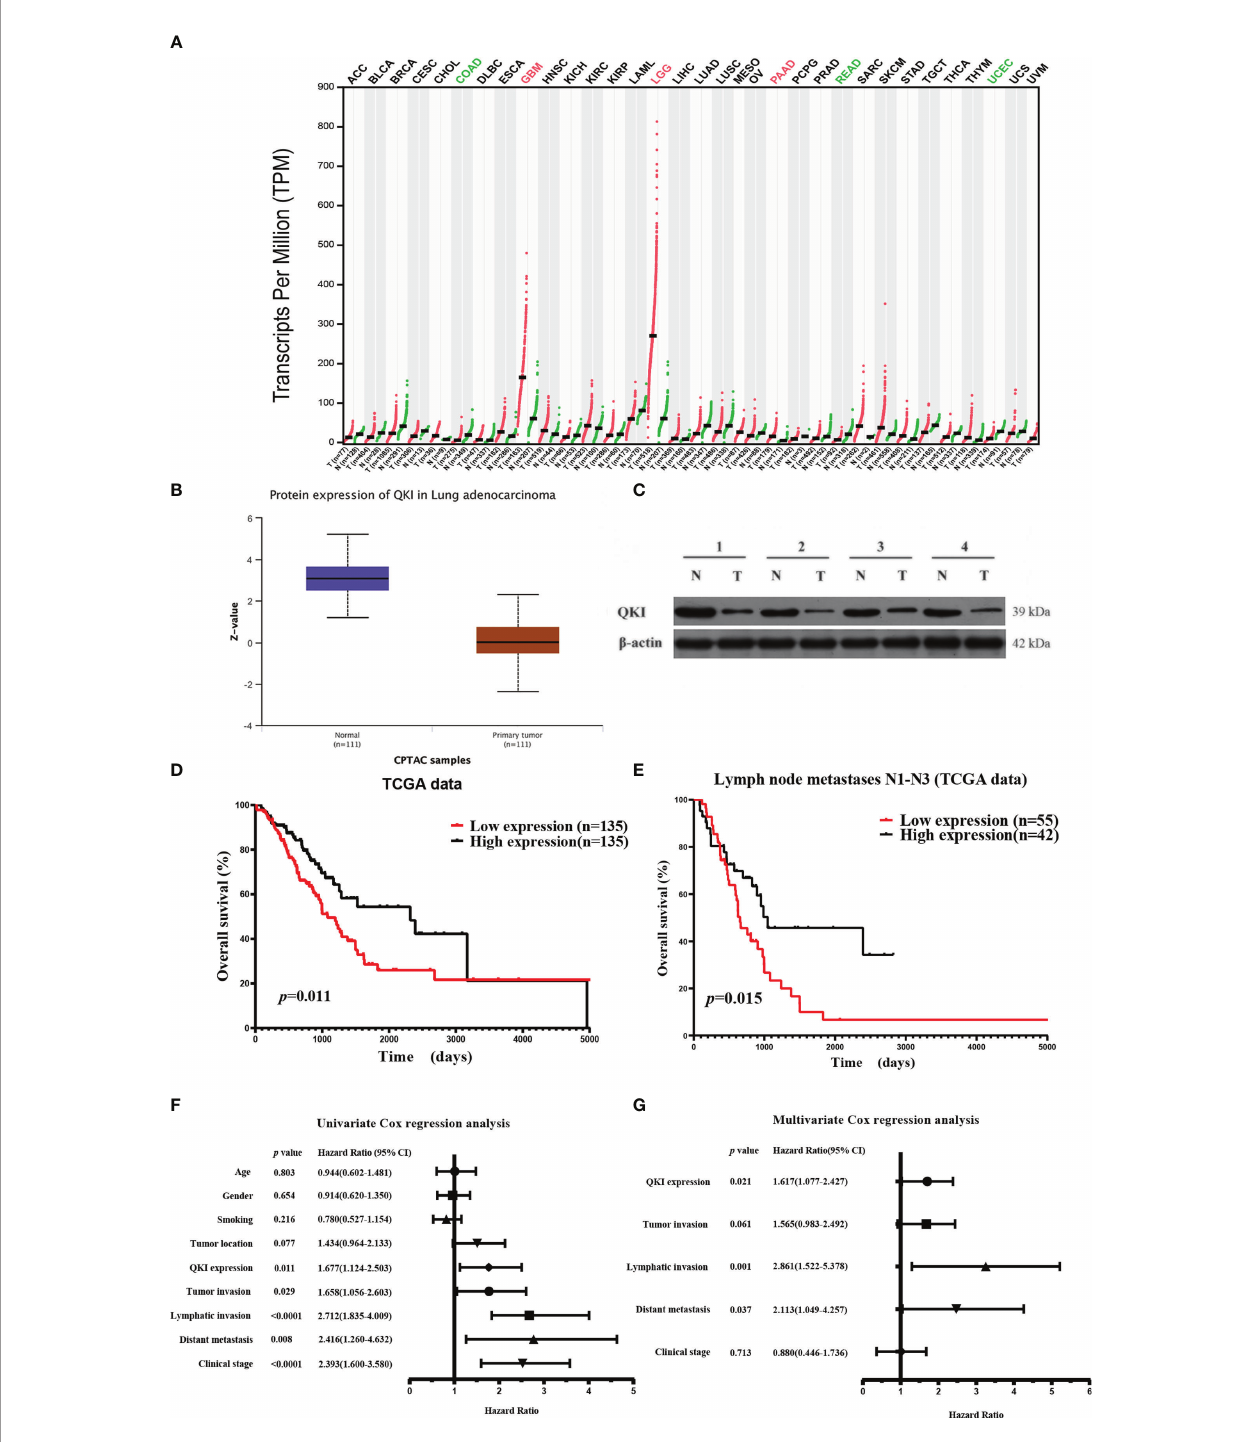
FIGURE 1 | Elevated QKI expression improved prognosis in patients with non-small lung cancer (NSCLC). (A) QKI expression pro fi le across several tumor samples and paired healthy tissues. (B) QKI protein expression levels in lung adenocarcinoma (NSCLC) and normal tissue samples were analyzed using CPTAC samples ( P < 0.05). (C) QKI protein expression in tumor (T) and normal tissue (N) from four patients. (D) Kaplan – Meier (KM) overall survival (OS) analysis of QKI expression in lung adenocarcinoma by using the TCGA samples ( n = 270; low expression vs. high expression; HR = 1.67, 95% CI = 1.13 – 2.47, P = 0.011, log-rank test). (E) KM OS analysis of QKI expression in patients with NSCLC with lymph node metastases N1 – N3 in the TCGA samples ( n = 97; low expression vs. high expression; HR = 1.93, 95% CI = 1.15 – 3.23, P = 0.015, log-rank test). (F, G) Univariate (F) and multivariate (G) analyses of the association between OS and clinical characteristics and QKI expression in the TCGA